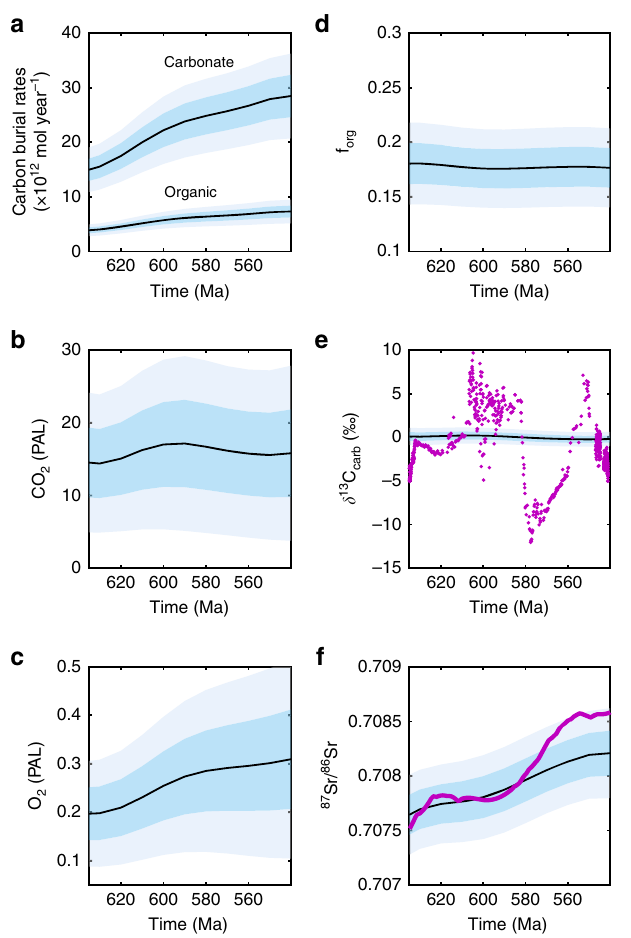
Fig. 5 Oxygen, carbon cycle and strontium isotope outputs. Monte-Carlo experiments running the COPSE model for the Ediacaran period. Degassing rates are sampled from the error window of Mills et al. (2017) 37 , uplift rates increase linearly from 0.5 to 2 times present day. Values for the key model parameters controlling atmospheric oxygen are chosen for each run from the ranges shown in Table 1. Light shaded windows show ± 1 std. dev, dark shaded windows show ± 0.5 std. dev. Geologic data in purple 45,67 . a Carbon burial rates. b CO 2 (PAL), c O 2 (PAL), d f org , e δ 13 C carb , f 87 Sr/ 86 Sr